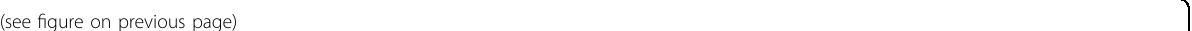
Fig. 1 Development of a novel full-human CD22-CAR FH80 construct and leukemic CD19/CD22 expression in patients before enrolling in CD22-CAR FH80 therapy. a Schematic of the recombinant lentiviral vectors encoding the full-human CD22-BBz variants. The expression of CAR transgene is under the control of the elongation factor 1 α promoter. CD8 (H/TM), CD8 α hinge and transmembrane domains; EGFR, epidermal growth factor receptor; T2A, Thoseaasigna virus 2A. b Histogram of CD22 expression on Raji, JVM-2, and K562 cells, determined by fl ow cytometry. c Nuclear factor of activated T cells (NFAT) reporter assay in T cells transduced with different CD22-BBz variants, after co-culturing with CD22 high Raji, CD22 low JVM-2, and CD22 - K562 cells, or cultured in medium alone in triplicates. d Bar chart showing CD107a expression in speci fi c CD22-BBz T cell clones after co-culturing with CD22 high Raji, Nalm6, Reh cells, CD22 low JVM-2, CD22 − K562, Jurkat, and U266 cells, as determined by fl ow cytometry. CD107a degranulation rates were calculated as the percentages of CD107a + cells among CAR + CD8 + T cells and indicated above each bar. e Cytolytic effects of speci fi c CD22-BBz T cell clones against Nalm6 and Reh cells during co-culturing in triplicates at E:T ratios of 2:1, 1:1, 0.5:1, and 0:1. % speci fi c lysis = (spontaneous relative light unit (RLU) − test RLU)/(spontaneous death RLU) × 100. A two-tailed, unpaired two-sample t -test was used for statistical analysis. The brown, green, and blue asterisks indicate the comparison of the cytolytic effects of CD22-BBz 80 with those of CD22-BBz 36, CD22-BBz 27, or control T cells, respectively. * P < 0.05, ** P < 0.01, *** P < 0.001, **** P < 0.0001. f Membrane proteome array for CD22-BBz. g Dot plots showing the proportions of blasts (red) and non-tumor cells (black) among all mononuclear cells from patients at the indicated time points, and contour plots showing CD22 and CD19 expression on blasts (red) before CD22-CAR YK002 and CD22-CAR FH80 T cell therapy, determined by fl ow cytometry with a population of CD22-negative non-B cells with similar cell size in the same staining tube (blue) as a negative control for evaluating CD22 expression level. The blasts were de fi ned based on the combined analysis of multiple markers. The number represents the proportion of blasts (red) in the four quadrants. h Histogram and mean fl uorescence intensity of CD22 cell-surface expression in patients 03 and